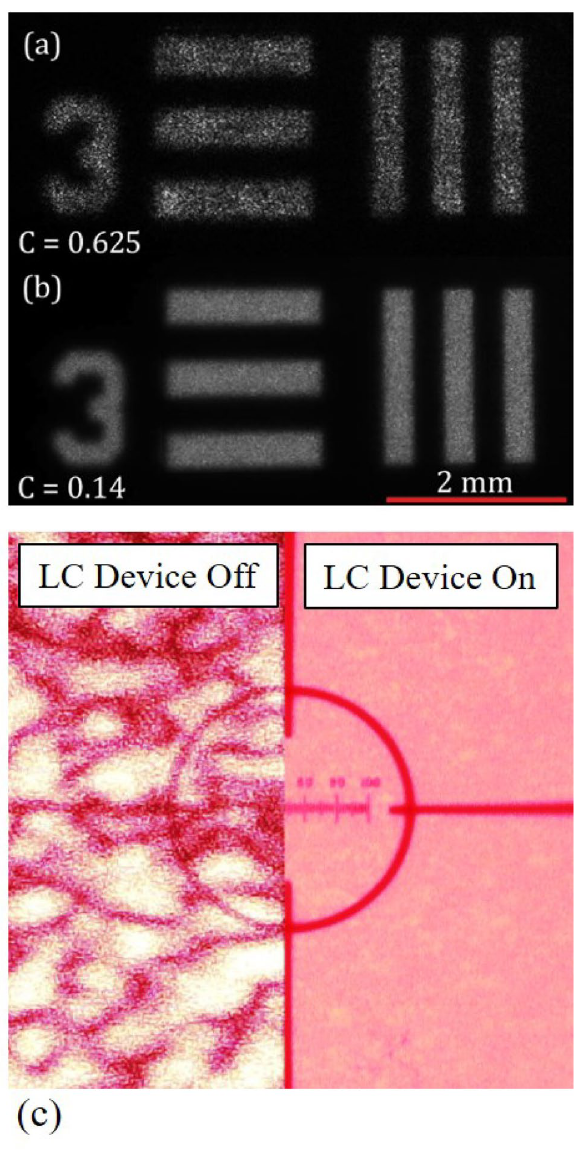
Figure 8. Images captured by the CCD of the white screen when an image of the 1951 USAF target is generated without ( a ) and with ( b ) a chiral nematic LC device (E7 + 4.7 wt% BDH1281, pitch = 310 nm). ( c ) Image showing that the resolution is preserved during the speckle reduction process. The left-hand and right-hand images show the speckle pattern for the case when the LC speckle reducer is switched off or on, respectively. An image of a microscope stage micrometer can be seen showing a scale bar from 0 to 100 µm. The device thickness was nominally 20 µm and measurements were carried out at T = 25